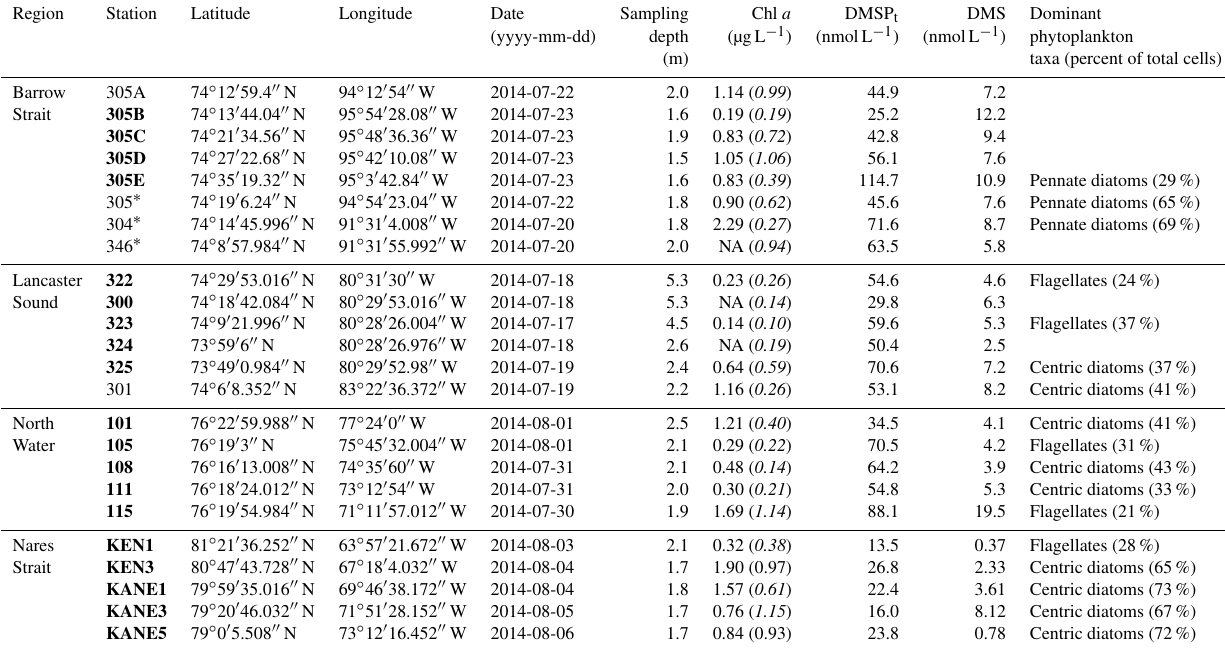
Table 2. Biogeochemical characteristics (including concentrations of DMSP t and DMS) of the surface waters sampled during the ArcticNet– NETCARE campaign during July–August 2014 grouped within different regions of the Arctic. Chlorophyll a is denoted as Chl a , and values in italic and parentheses represent in vivo fluorescence. Percentage of dominant phytoplankton taxa is shown for stations where it was available. Ice-covered stations are marked with an asterisk. Stations in bold are included in the vertical cross section transect figures (Figs. 4 to 7). Values that were not available are denoted as “NA”.